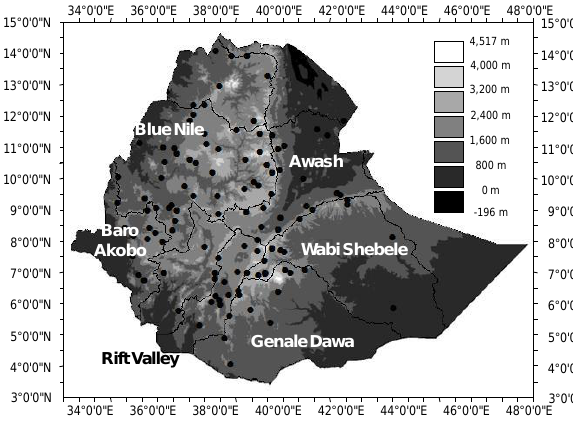
Figure 1 – Six River Basins of Ethiopia Evaluated and Associated Rain Gauges Fig. 1. Six river basins of Ethiopia evaluated and associated rain